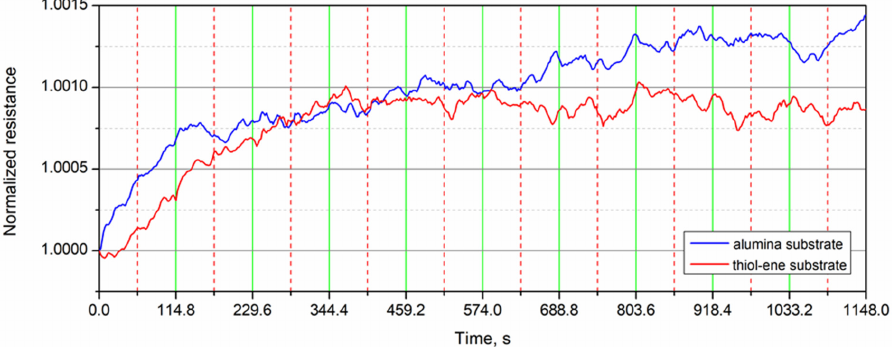
Figure 10. Normalized resistance of the PEDOT:PSS films versus time over 10 cycles of applied strain. The vertical dashed red lines correspond to the maximum load and the solid green lines correspond to zero load.